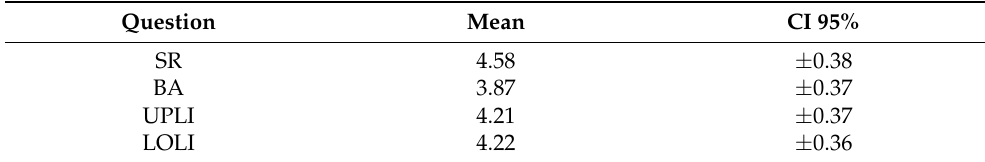
Table 6. Perception on the influence of Cyb in